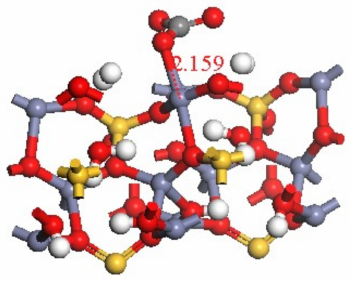
Figure 11. Bond length of